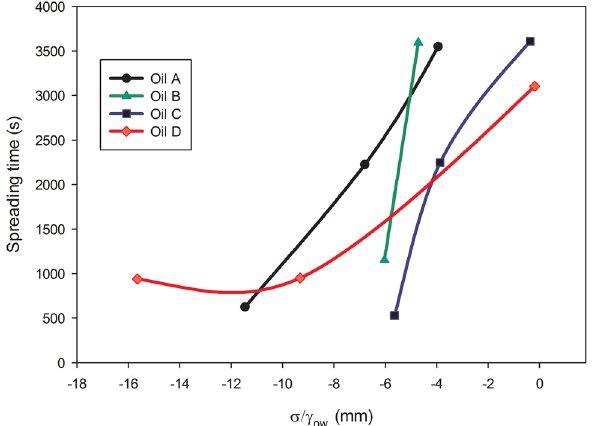
Fig. 10 Spreading time versus IFT ratios for four crude oils and HS SDBS, HS